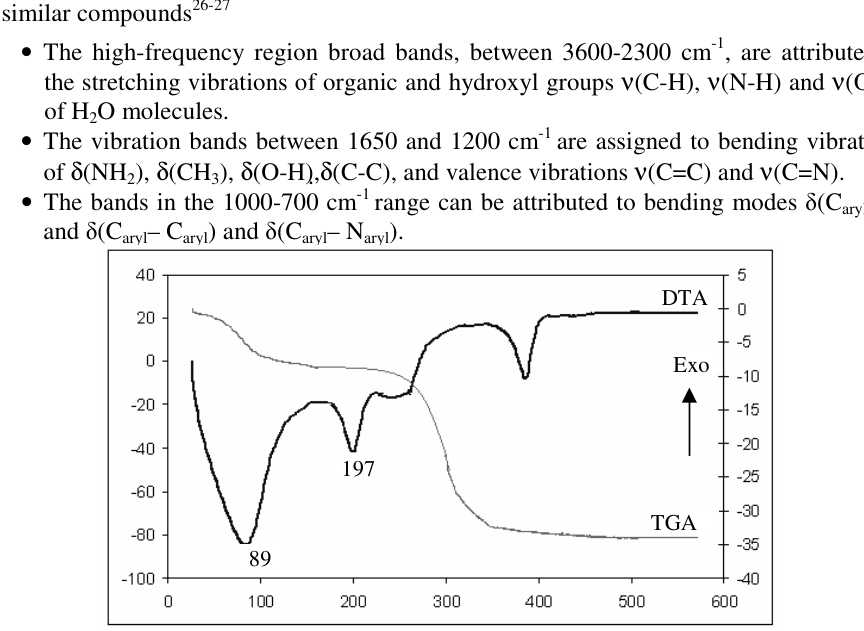
Figure 5 . Thermal analysis curves (DTA and TG) under argon of [2,6-(CH C H NH ] ZnCl .2H 6 3 3 2 4 2